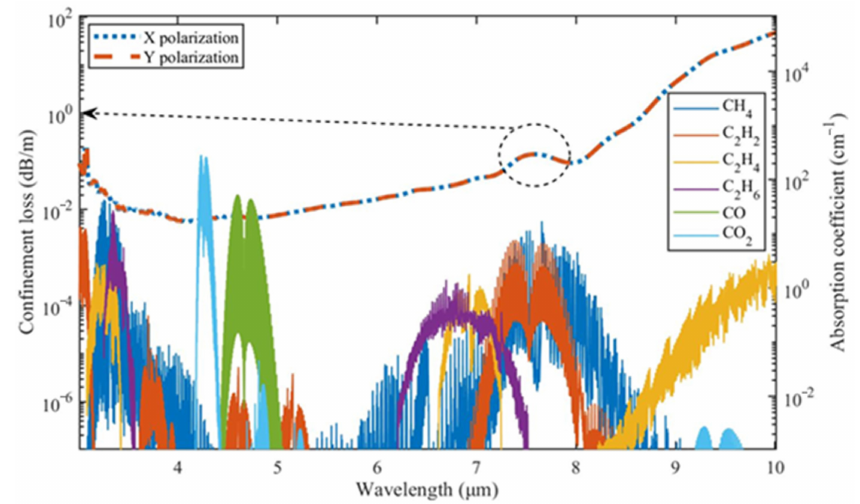
Figure 4. Confinement loss spectrum of the HCF and gas absorption spectra between 3 µ m and 10 µ